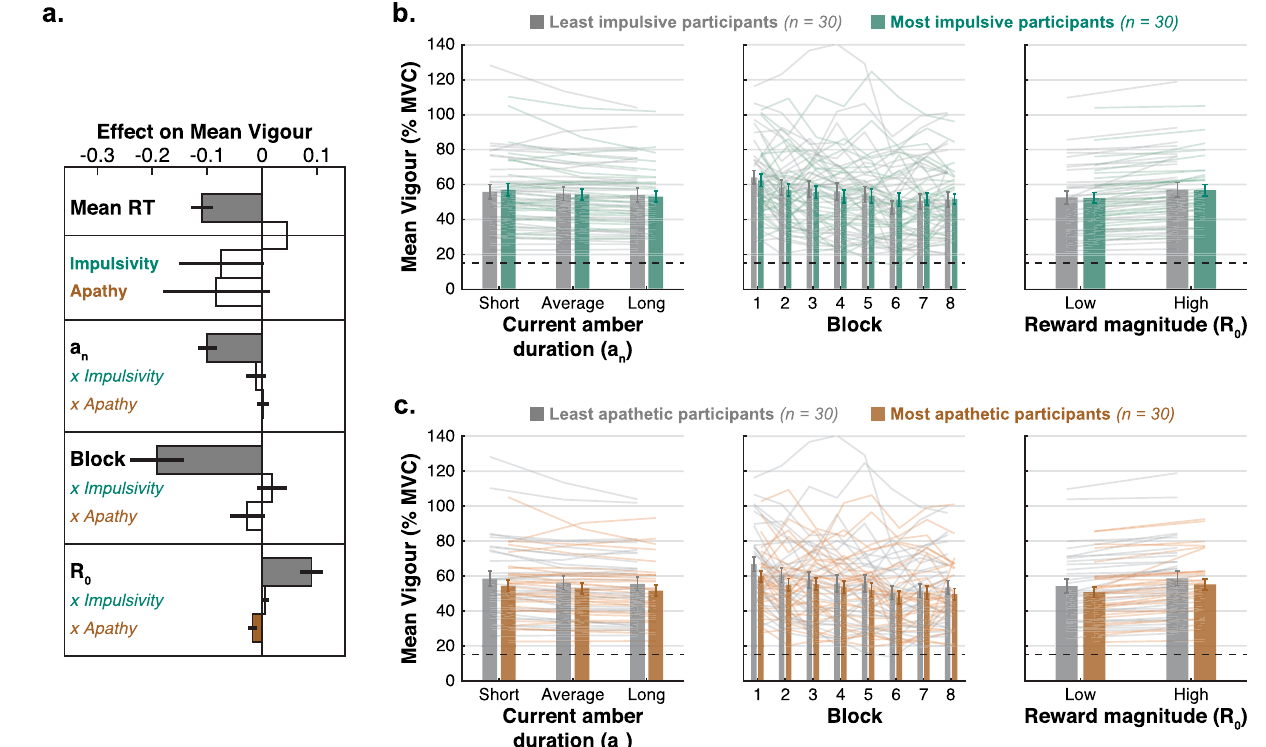
Figure 4. Apathy is associated with blunted valuation of reward. ( a ) Parameter estimates of the linear mixed- effect model of mean Vigour (model controlling for Age and Gender; see Table S4—Model 2). Coloured bars show significant effects ( p < 0.05 ) and white bars non significant effects with standard error.